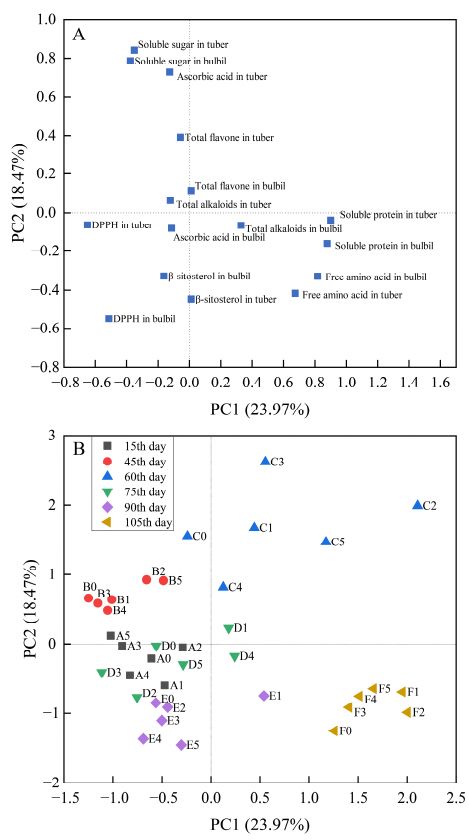
Figure 2. Principal component analysis (PCA) loading ( A ) and scores ( B ) showing correlation of yield and quality parameters in tubers and bulbils of P. ternata with PC1 ‐ PC2 at different stages after BR treatments. A, 15th day; B, 45th day; C, 60th day; D, 75th day; E, 90th day; F, 105th day. 0, 0.00 mg/L BR; 1, 0.05 mg/L BR; 2, 0.10 mg/L BR; 3, 0.50 mg/L BR; 4, 1.00 mg/L BR; 5, 2.00 mg/L BR. PCA was performed on the correlation matrix of values of yield and quality in the tubers and bulbils of P. ternata .